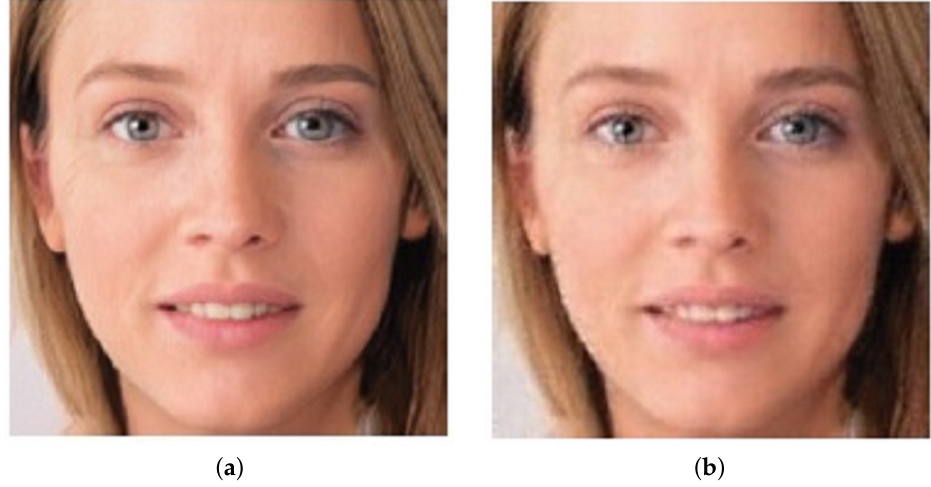
Figure 10. Deepfake and GANprintR-processed deepfake: ( a ) Deepfake, ( b ) deepfake after GAN- printR